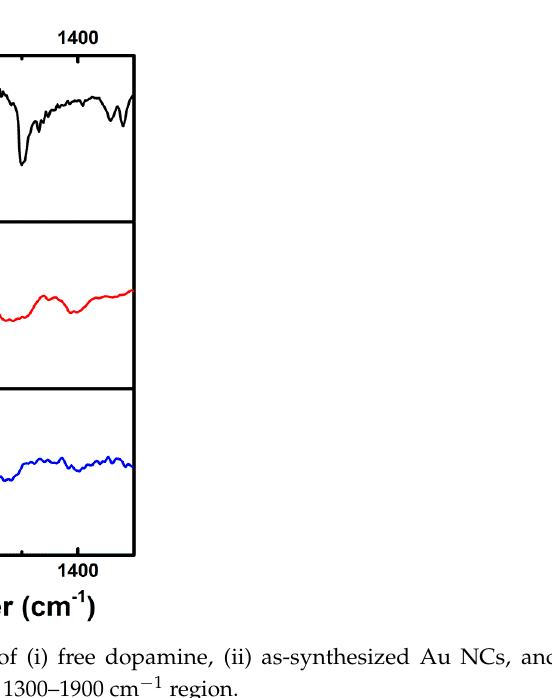
Figure 2. FT-IR spectra of (i) free GSH and (ii) as-synthesized Au NCs in the 1000–2800 cm − 1 region.